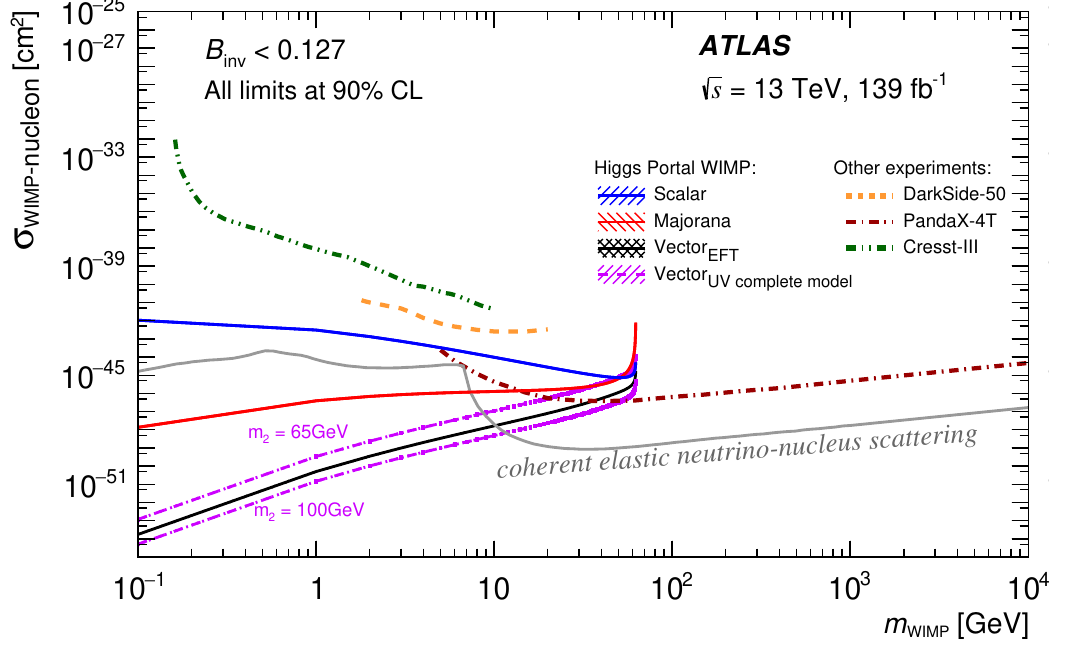
Figure 13. Upper limits on the spin-independent WIMP-nucleon cross section using Higgs portal interpretations of B at 90% CL vs m . For the vector-like WIMP hypothesis, the dependence inv WIMP on the mass m of the new scalar particle, which is often predicted by renormalisable models, is 2 shown for two different values taken from ref. [151]. For comparison with direct searches for DM, the plot shows results from refs. [146–148]. The neutrino floor for coherent elastic neutrino-nucleus scattering is taken from refs. [153, 154] and assumes germanium as the target over the whole WIMP mass range. The dependence on the choice of target nucleus is relatively small, given the large range of cross sections